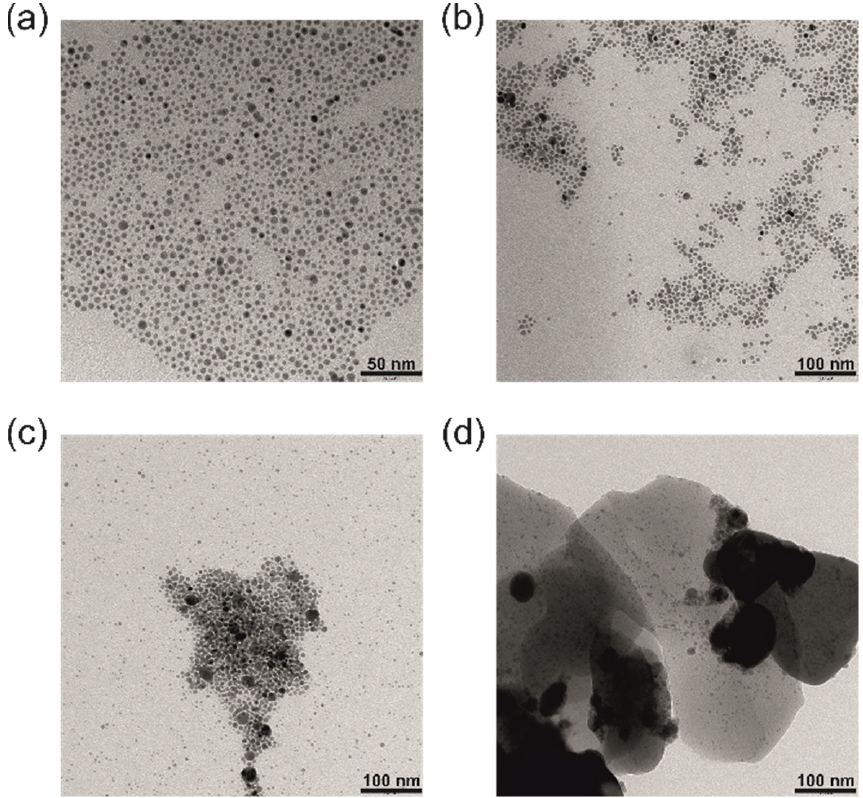
not changed; after the fourth cycle, the fraction of bigger nanostructures is visible; after the eleventh cycle, aggregated structures with a size of even 100 nm are visible but still small nanoparticles are present and thanks to this the catalyst is still active.